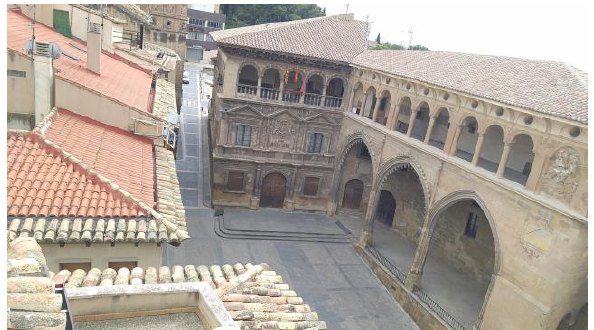
Figure 1. Exterior from the Town Hall of Alcañiz